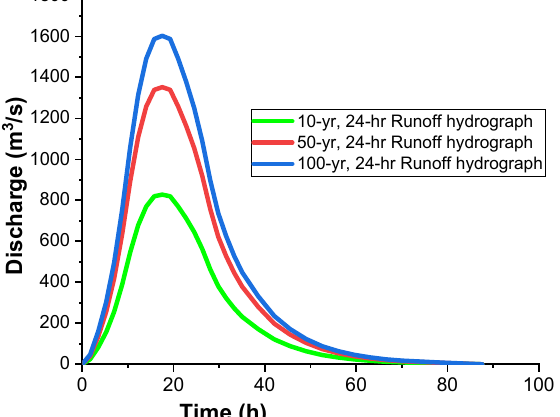
Figure 14. The Soil Conservation Service storm hydrograph of different return periods for the study area.